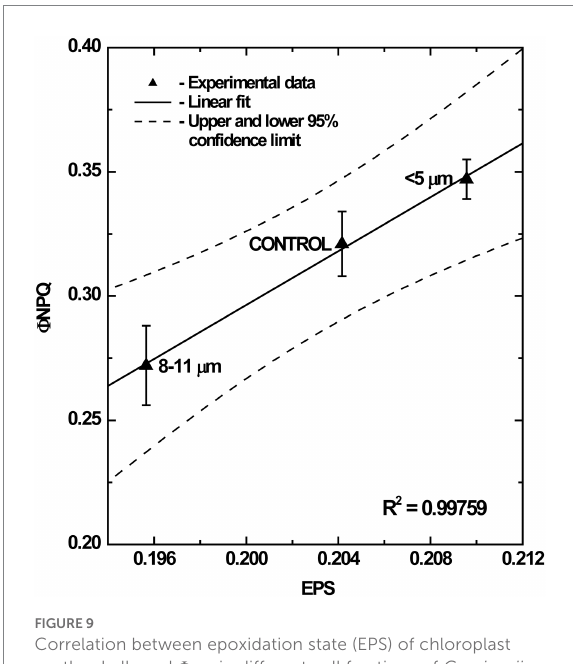
FIGURE 9 Correlation between epoxidation state (EPS) of chloroplast xanthophylls and Φ NPQ in different cell fractions of C. priscuii grown at grown under steady-state temperatures of 8 ° C. All values represent means ± SE from 4 independent measurements.